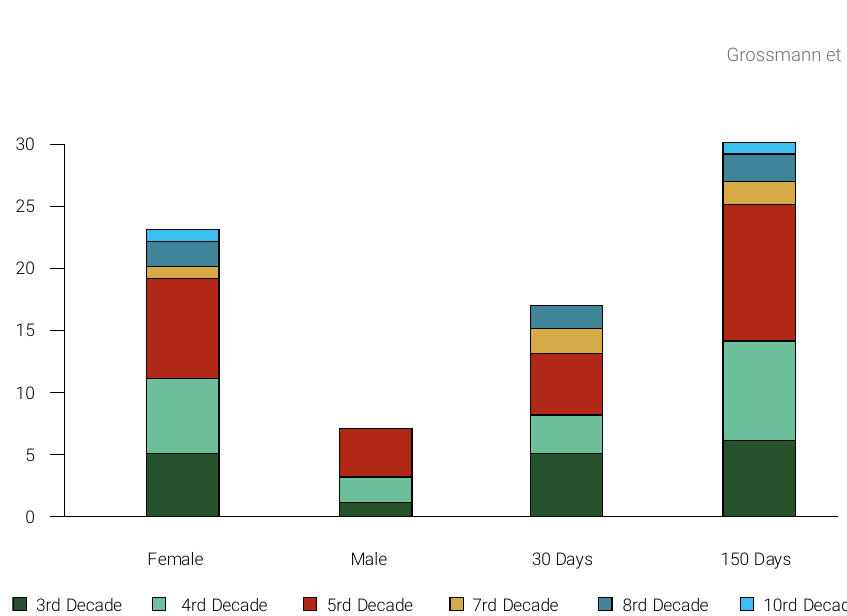
Figure 2. Relative distribution of questionnaires according to sex and age during the initial 30 days and after 150 days from the start date of the